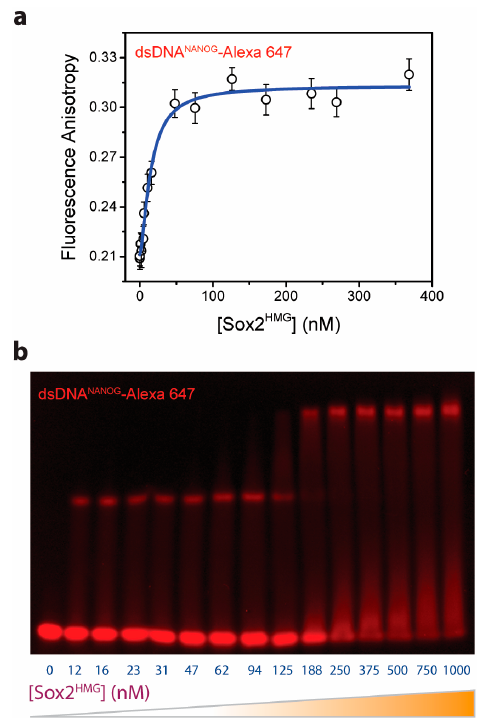
Figure 1. Sox2 cooperatively binds to the NANOG upstream promoter (DNA NANOG ). ( a ) DNA binding of Sox2 HMG was probed by monitoring changes in fluorescence anisotropy of Alexa Fluor 647 ‐ labeled dsDNA with increasing [Sox2 HMG ]. The solid line represents nonlinear least squares (NLS) fit of the data to a Hill equation. NLS ‐ derived parameters: K D = 15.1 (±2.0) nM, Hill coefficient = 1.5 (±0.3). ( b ) Fluorescence electrophoretic mobility assay (fEMSA) of Sox2 HMG ‐ DNA NANOG binding suggests a multistep Sox2 HMG complex formation with dsDNA NANOG involving multiple protein molecules that are able to bind the DNA partner. (See also Figure S2.)